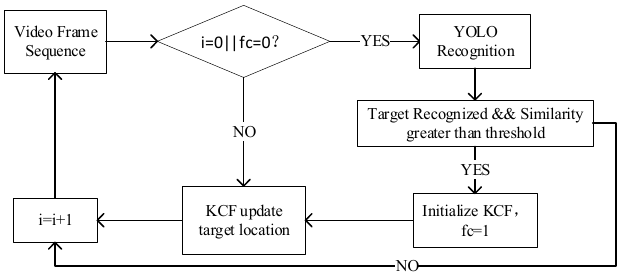
Figure 7. Autonomous initialization tracking combined with object recognition.